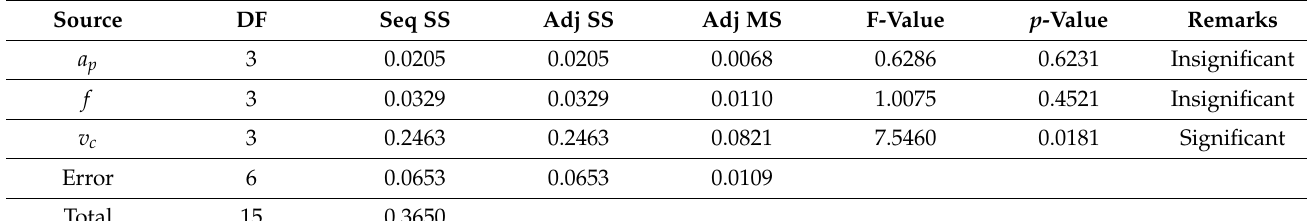
Table 7. Results of ANOVA on grey relational